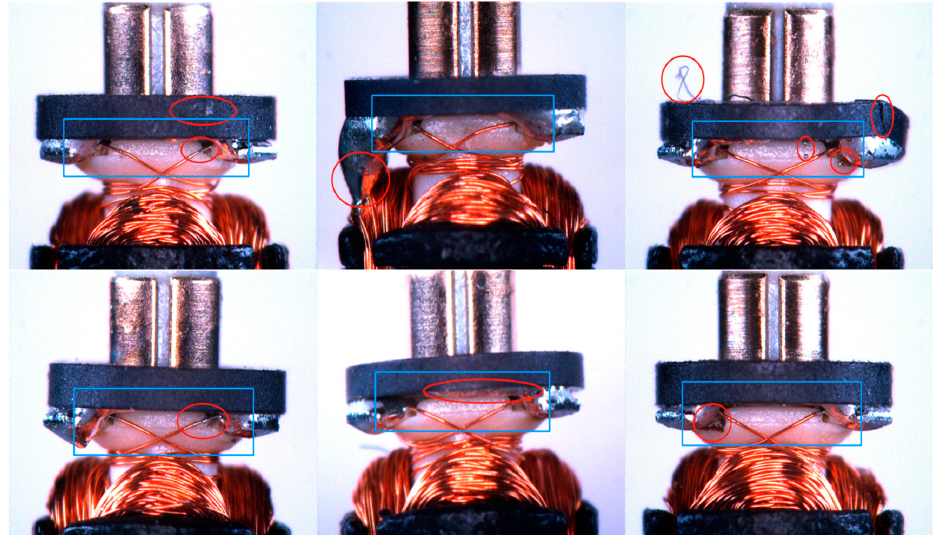
Figure 4. Original image samples taken by the device showed is Figure 2. The defective regions are marked out by a surrounding red ellipse; the ROC is marked by a blue rectangle.